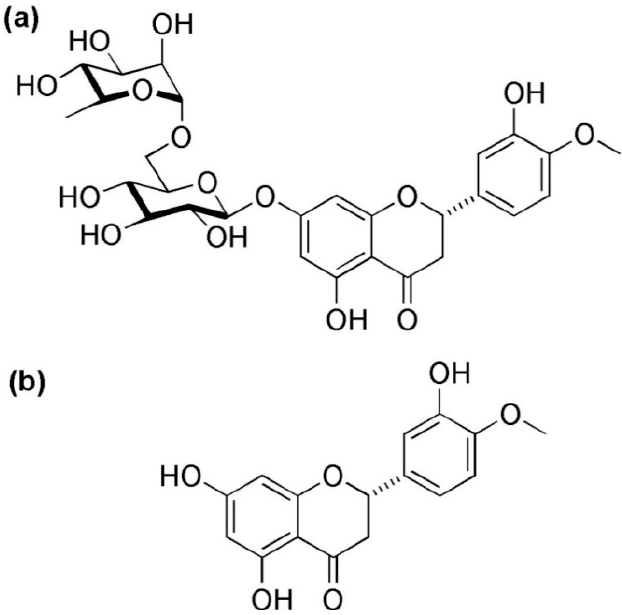
Figure 1. Chemical structures of hesperidin ( a ) and hesperetin ( b ).